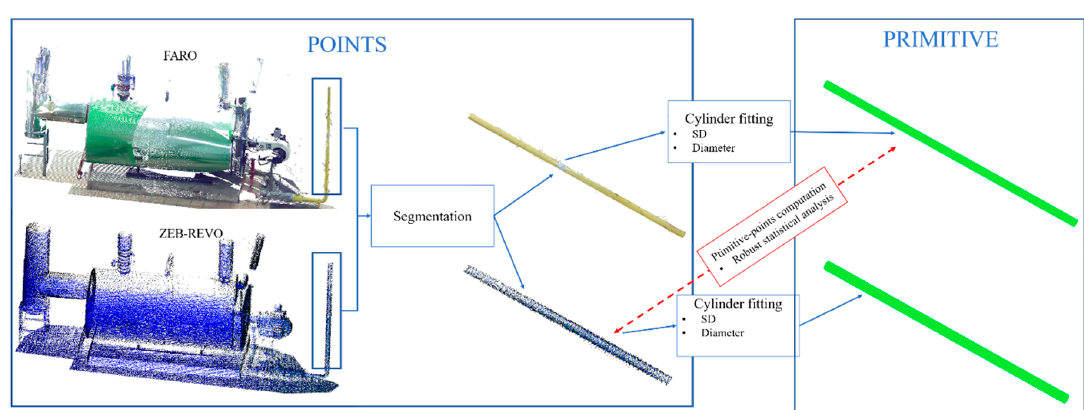
Figure 8. Procedure used to compare the different point clouds in pipes regions. The same procedure is following to compare the plane regions.